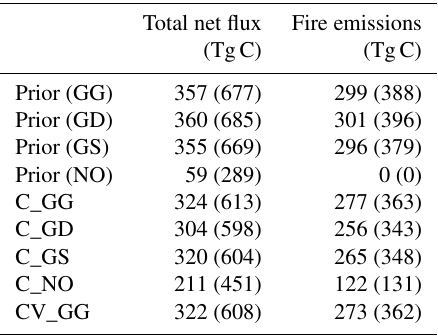
Figure 6. Time series of CO mole fractions obtained by the in situ NIES VOS measurement (black) for September (a) and October (b) and corresponding simulation results by NICAM-TM with prior CO emissions data (red). These time series depict the data limited within the range of 95–125 ◦ E and 10 ◦ S–15 ◦ N consistently with Fig. 5b and d. Model simulations only from fire emissions in Suma- tra and Borneo are denoted by blue and cyan colours, respectively. Grey shades with P# indicate the fire-induced elevated mole fraction events. Table 3. Total net flux and fire emissions of carbon from Equatorial Asia for September–October 2015. Figure 1 defines the geograph- ical region of Equatorial Asia. Note that the total net flux includes terrestrial biosphere fluxes, biomass burnings emissions and fossil fuel emissions. Annual flux values for 2015 are also noted in paren- theses. The prior fluxes with the four biomass burning emissions are presented as well as the posterior fluxes of the five